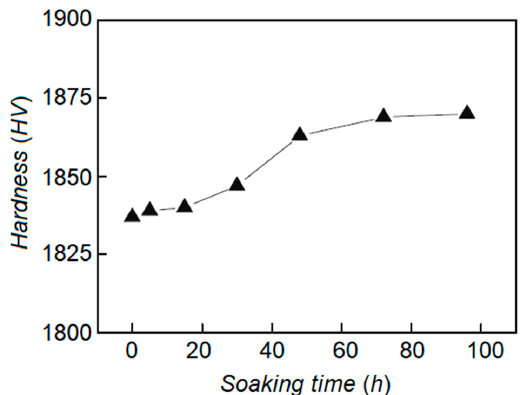
Figure 4. The effect of soaking time on hardness variation of the ultrafine-grained WC–12Co cemented carbide [51].